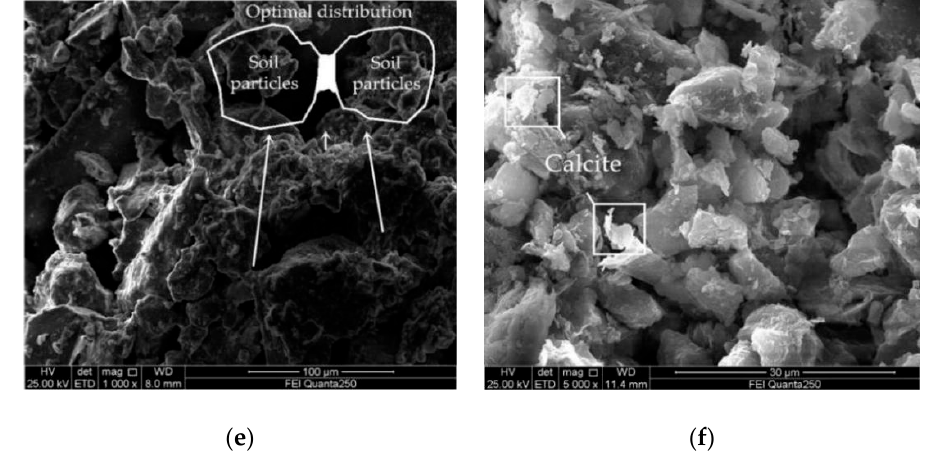
Figure 12. SEM images for untreated soil at ( a ) 1000 × magnification and ( b ) 5000 × magnification, for EICP-treated soil at ( c ) 1000 × magnification and ( d ) 5000 × magnification, and for soil treated by EICP with skim milk powder added at ( e ) 1000 × magnification and ( f ) 5000 × magnification.